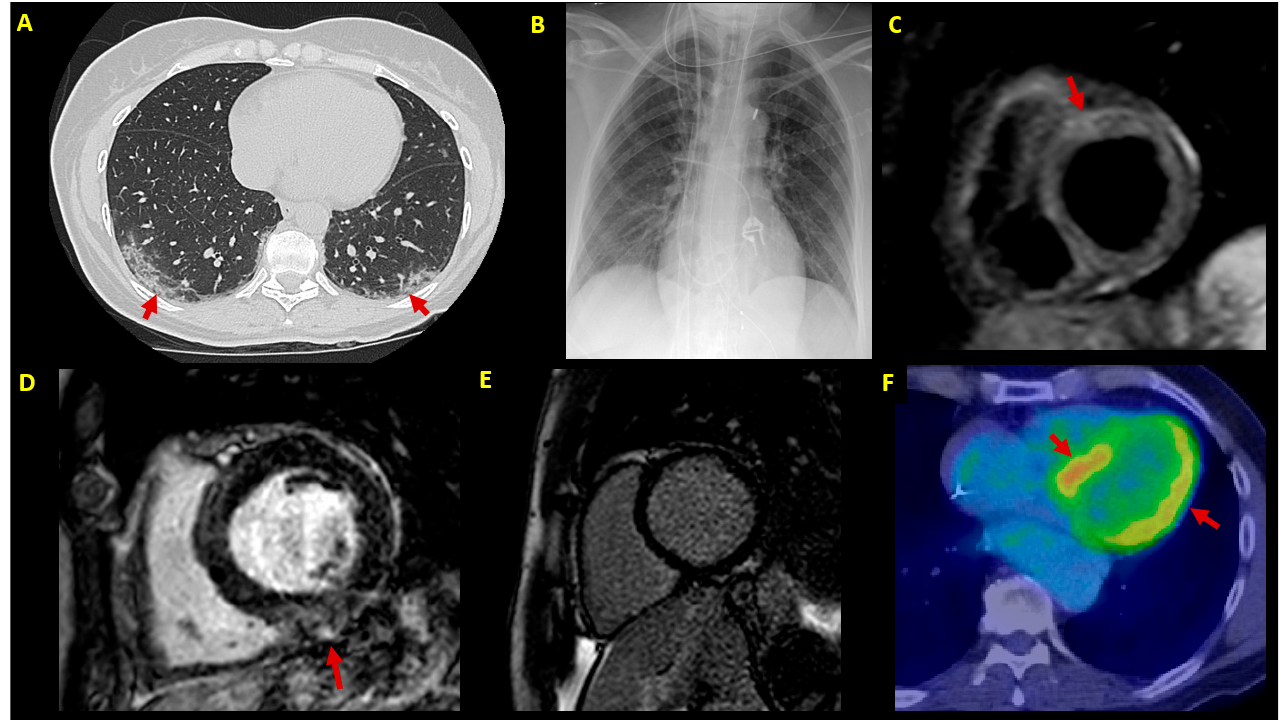
Figure 2. Imaging findings. Imaging findings at patient (P1–P7) diagnostic workup. ( A ) Chest CT scan showing bilateral patchy ground-glass opacities (arrows) (P3); ( B ) chest X-ray in a patient (P7) with cardiogenic shock supported by IABP, VA-ECMO and temporary pacemaker; ( C ) CMR in a patient with infarct-like acute myocarditis associated with COVID-19 (P3); T2-STIR sequence shows edema in the anterior basal segment (arrow); ( D ) LGE sequences in a patient (P5) showing mild inferior mid-myocardial/subepicardial LGE (arrow); ( E ) absence of LGE by 3-month follow-up CMR in a patient (P4) with fulminant myocarditis at presentation; ( F ) 3-month follow-up FDG-PET scan in an ICD carrier (P5) with virus- negative myocarditis; abnormal left ventricular FDG uptake is shown (arrows). CMR = cardiac magnetic resonance; CT = computed tomography; EMB = endomyocardial biopsy; FDG-PET= 18F-fluorodeoxyglucose positron emission tomography; IABP = intra-aortic balloon pump; ICD = implantable cardioverter defibrillator; LGE = late gadolinium enhancement; LVEF = left ventricular ejection fraction; STIR = short-tau inversion recovery; VA-ECMO = venoarterial extracorporeal membrane